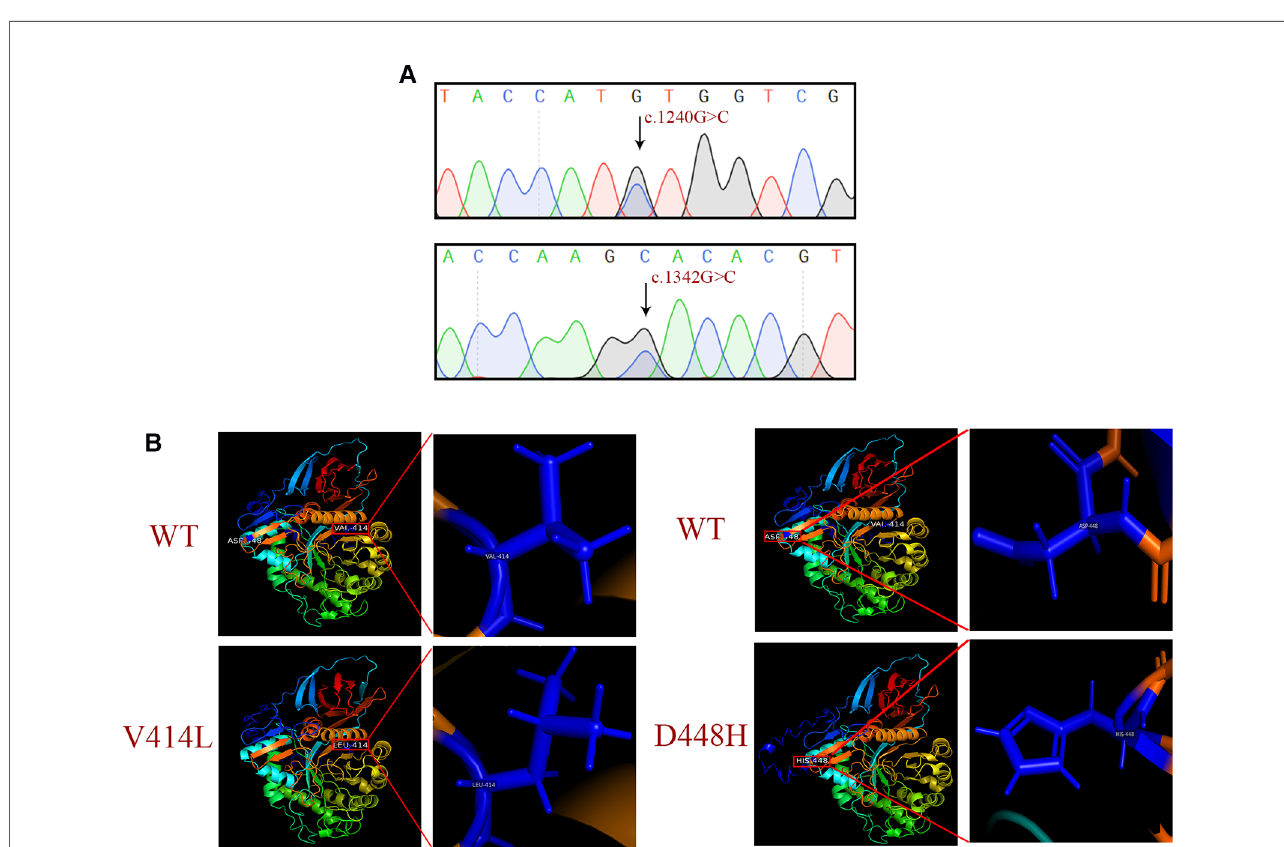
FIGURE 2 Sequencing chromatogram and bioinformatics analysis. ( A ) Sanger sequencing results of the c.1240G>C (p.Val414Leu) and c.1342G>C (p.Asp448His) mutations. ( B ) Protein structure predicted by